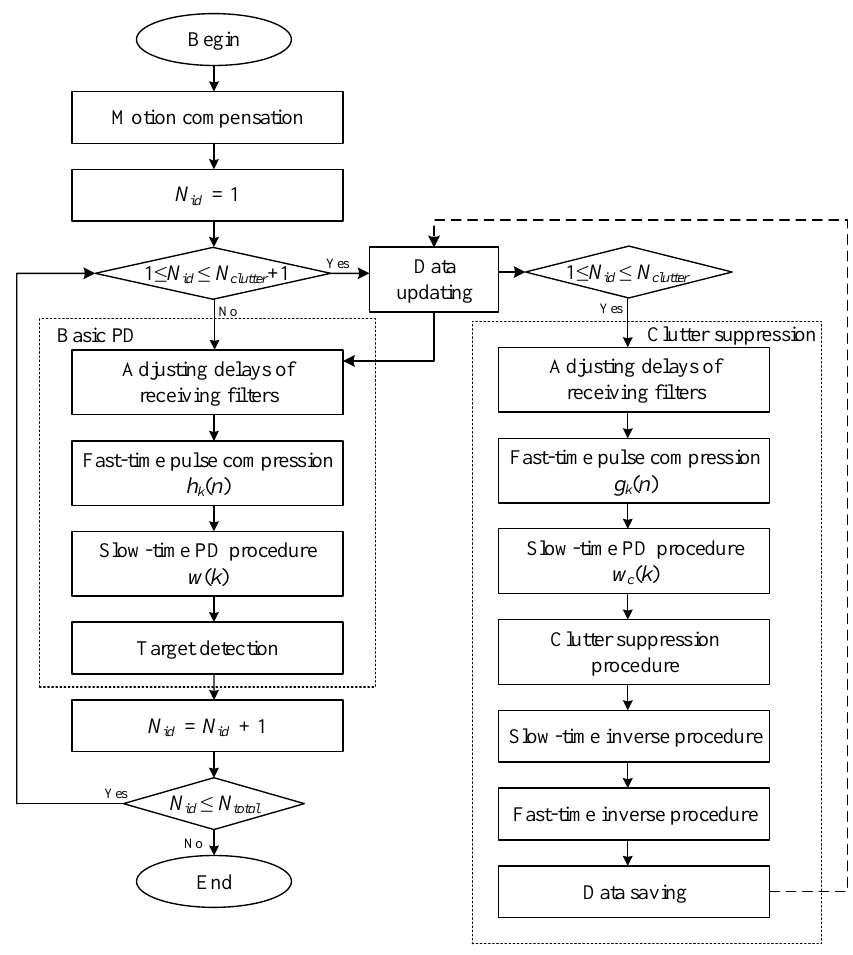
Figure 5. Pulse Doppler (PD) process flowchart.